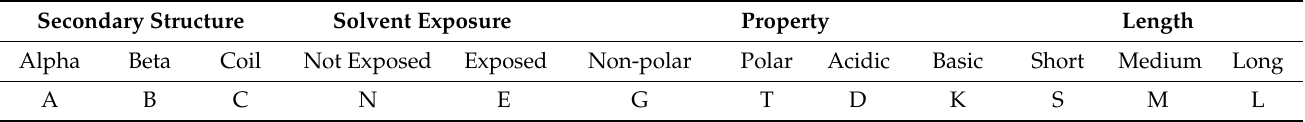
Table 7. Representation of the protein SPS